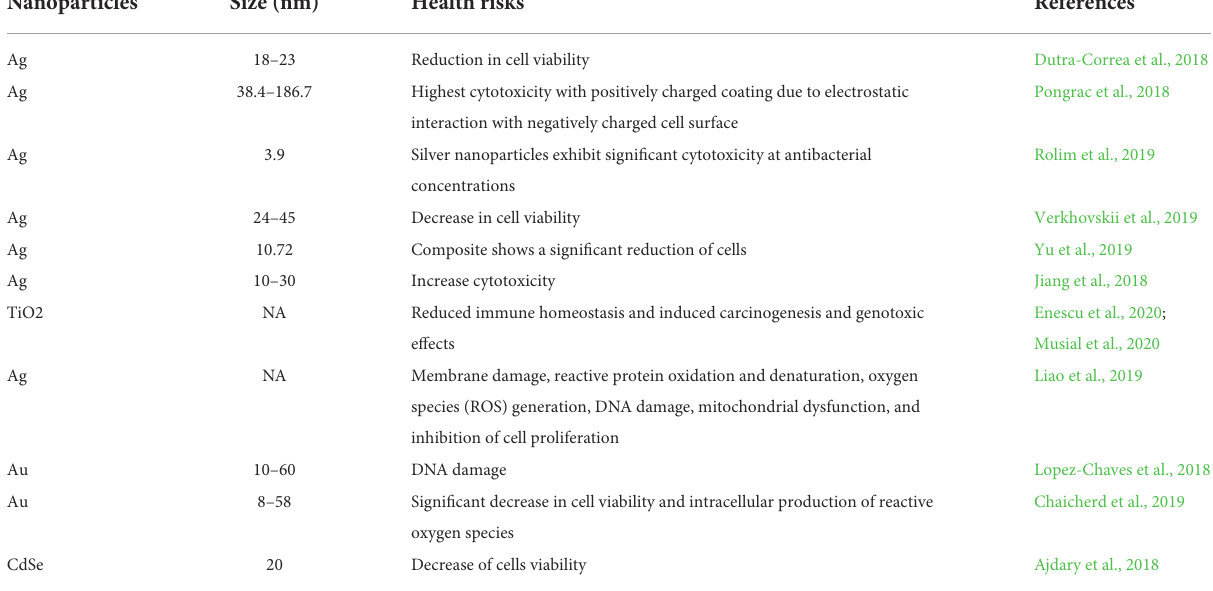
TABLE 3 Nanoparticles and their health risks related to humans and other